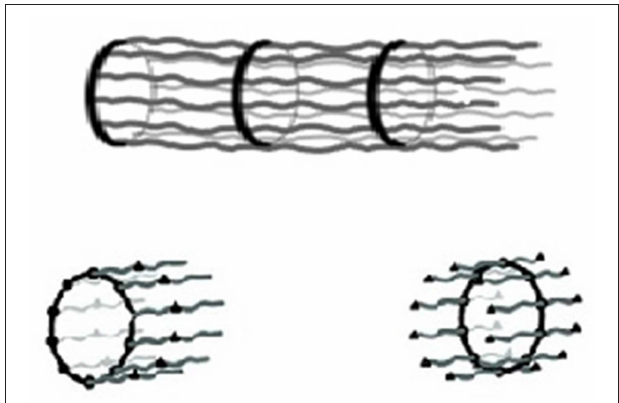
FIGURE 2 | (Top) Schematic representation of the structure of the axon: a rigid sequence of adducin-capped actin rings connected by rigid spectrin tetramers with a periodicity along the axon axis of 180–190nm. (Bottom) Possible monomeric units (Xu et al., 2013; Ciferri,